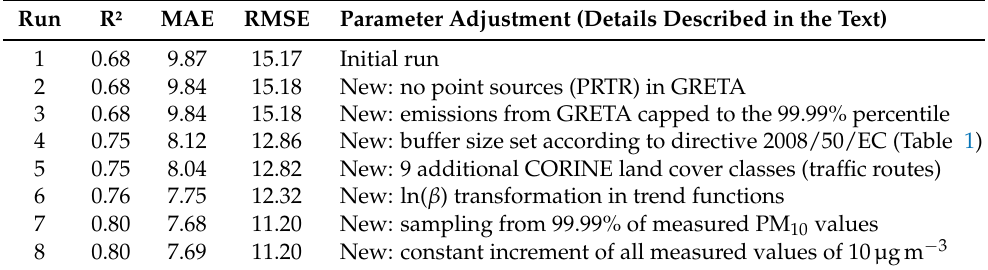
Table 2. Parameter adjustments and corresponding metrics of the leave-one-out cross-validation (loo-cv) of all runs during the optimisation process with dataset (1) (MAE and RMSE in µgm − 3